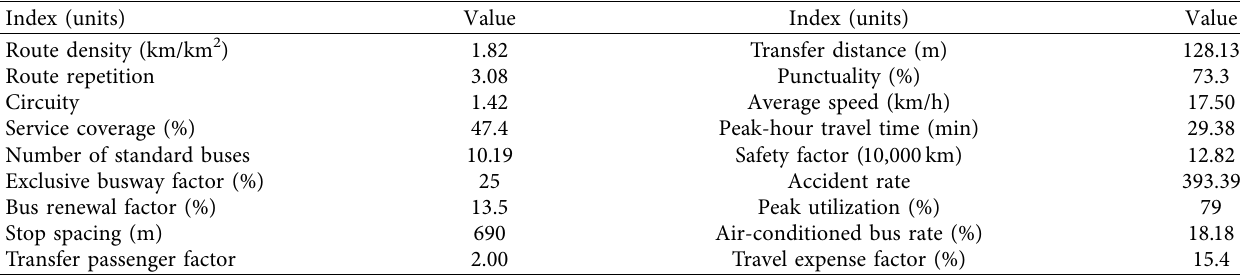
Table 4: Survey results of the study bus